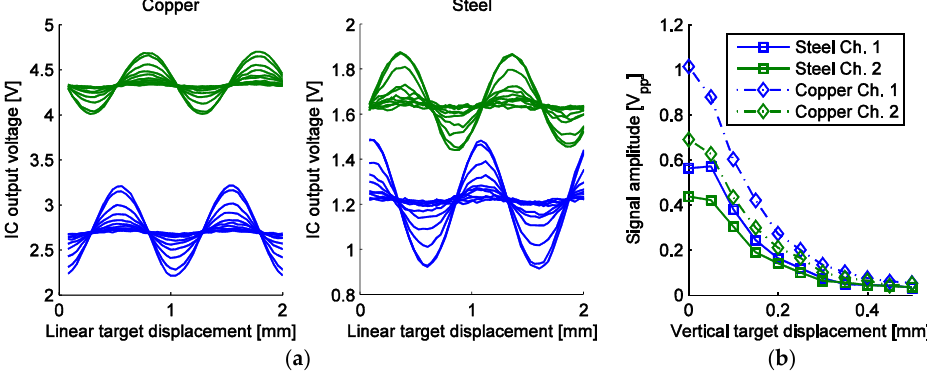
Figure 16. The results of the microsystem vertical target displacement sweep for both scale types; ( a ) the measured IC output voltages for both channels at all vertical target positions; ( b ) The relation of the measured V pp voltages from ( a ) to the vertical target displacement. The linear starting position was arbitrary for both scales.